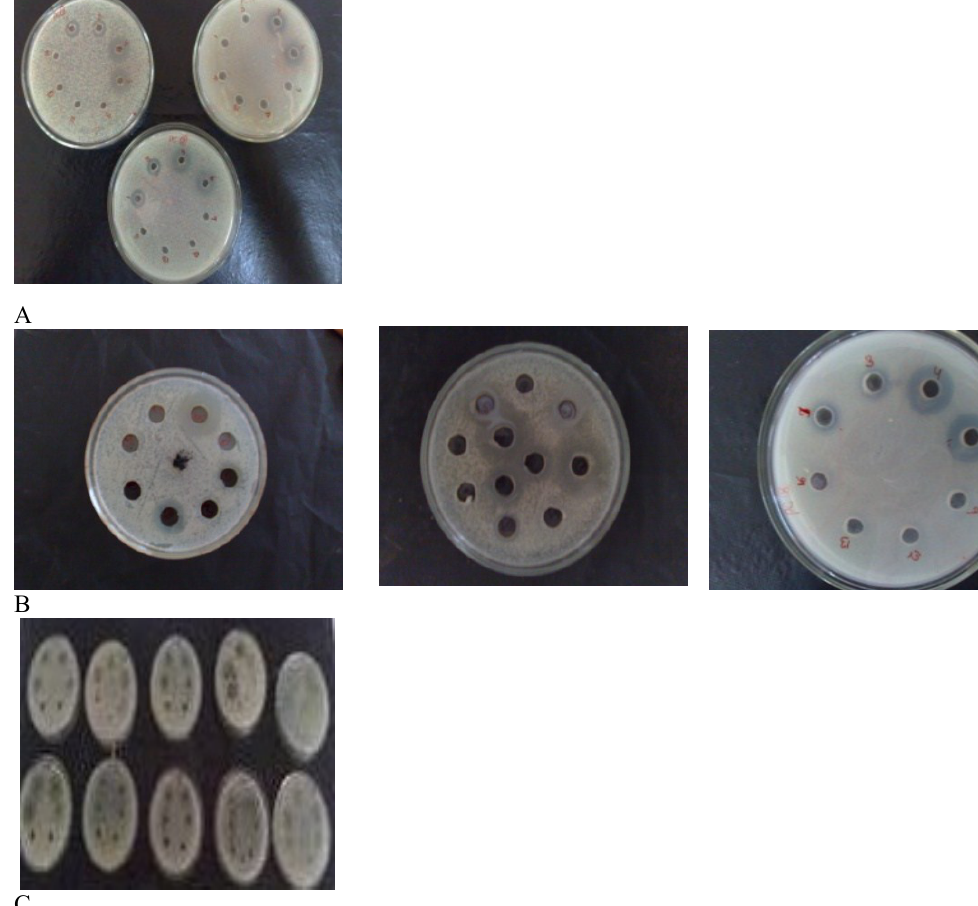
Figure 3. Secondary screening results of promising isolates against (Gram positive bacteria) Gram Negative bacteria and C (pathogenic